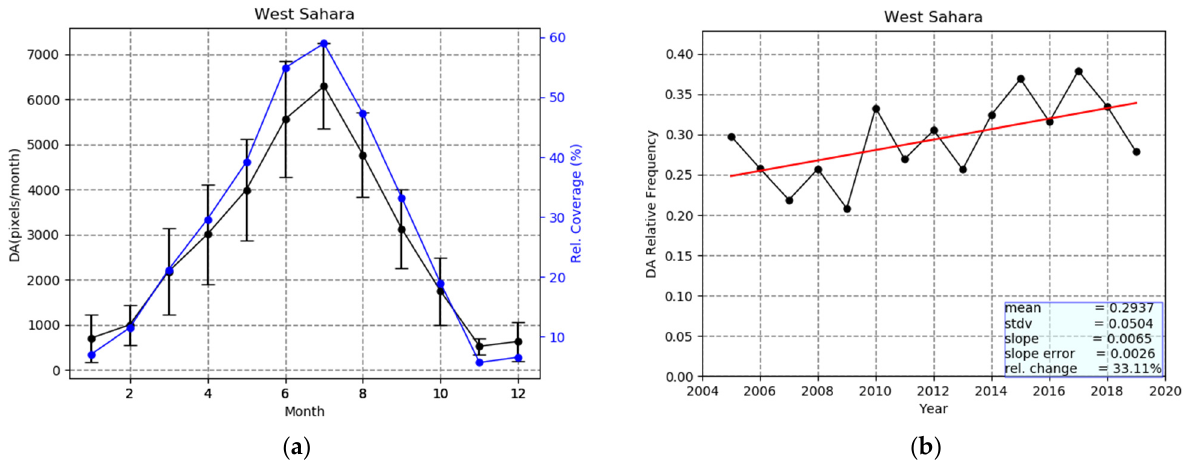
Figure 8. ( a ) Intra-annual variability of the 2005–2019 averages of the total absolute number of grid cells (1° × 1°) where dust aerosols (DA) were detected over West Sahara by the satellite algorithm (left axis) and the percent coverage of the region by dusty grid cells (right axis). The error bars represent the year-by-year variability by means of computed 2005–2019 standard deviations. ( b ) Inter-annual variability and linear trend of the relative frequency of dust aerosols (DA) over West Sahara.